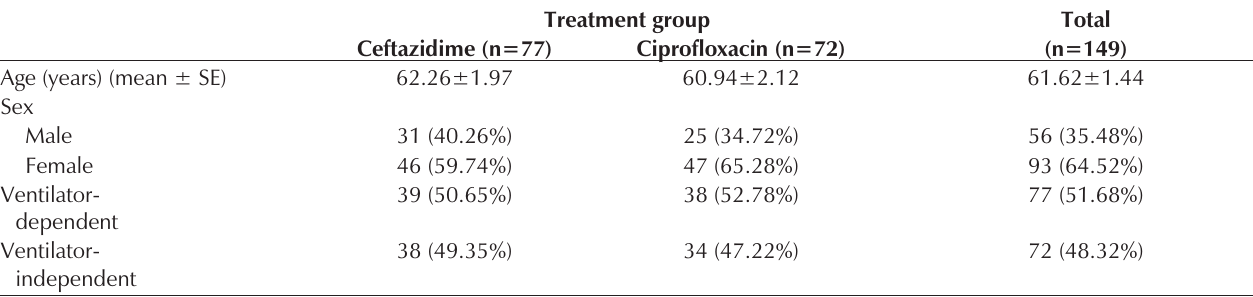
Treatment group